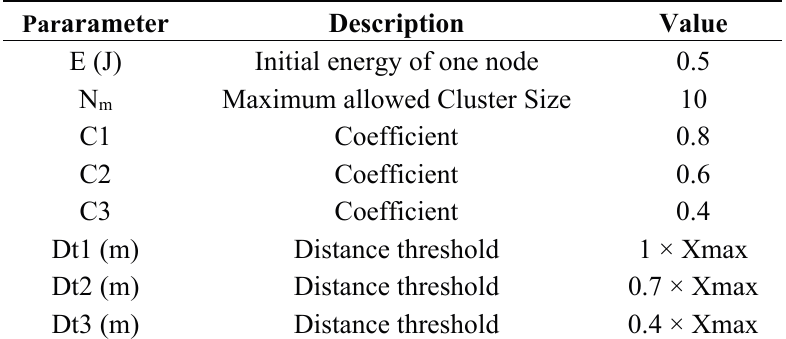
Table 3. The initial values.